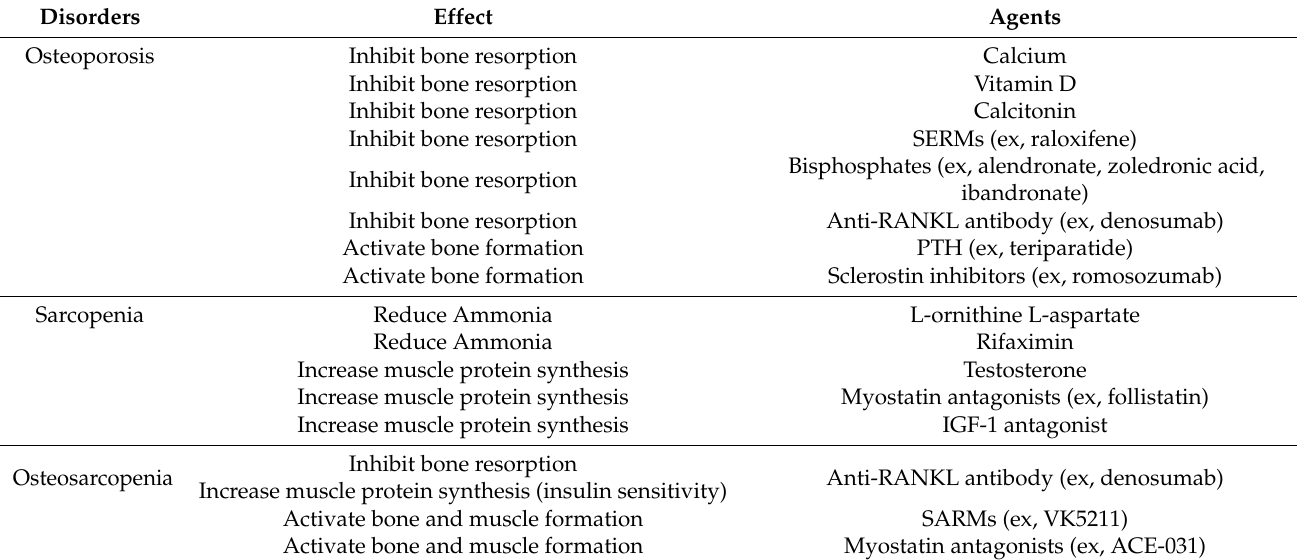
Table 4. Pharmacologic treatments of osteoporosis, sarcopenia, and osteosarcopenia.